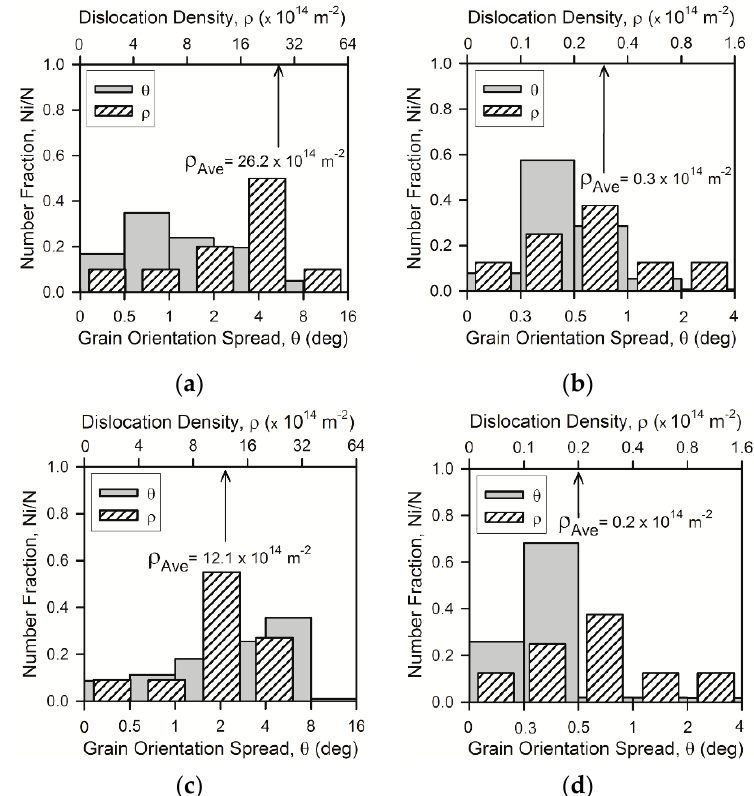
Figure 5. Distributions of the grain orientation spread and the dislocation density in a 316L-type steel subjected to cold rolling ( a, b ) or warm rolling ( c, d ) and subsequent annealing for 30 min at 973 K ( a, c ) or 1073 K ( b, d ).